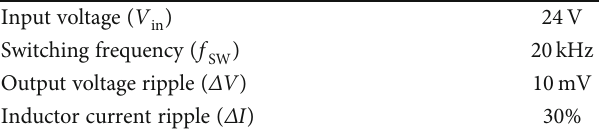
Table 2: Design parameters of buck